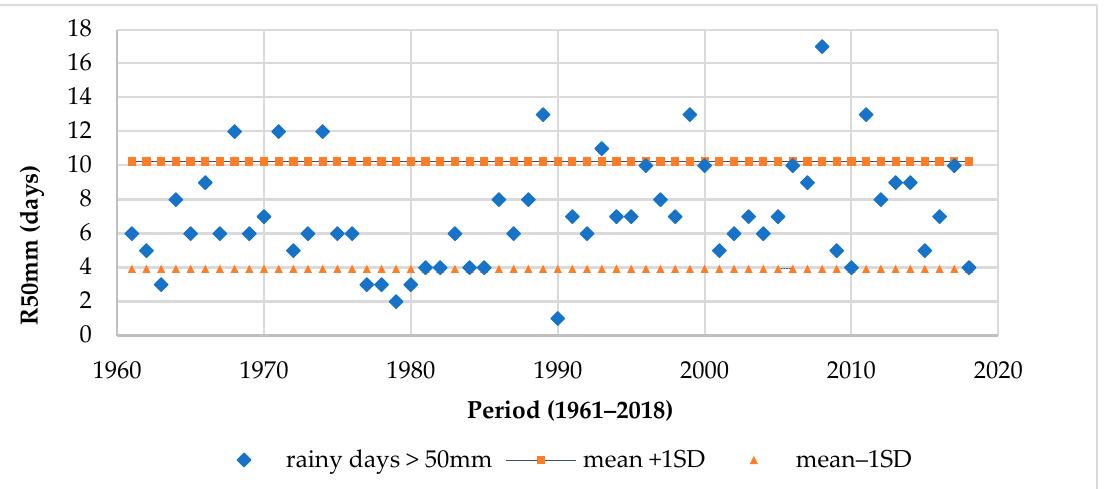
Figure 4. Temporal distribution of the R50mm index in the period from 1961 to 2018. Data from INMET station 82331, 2020. Elaborated by authors.